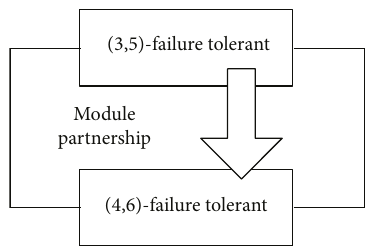
Figure 6: Reliability model of display function of IMA.